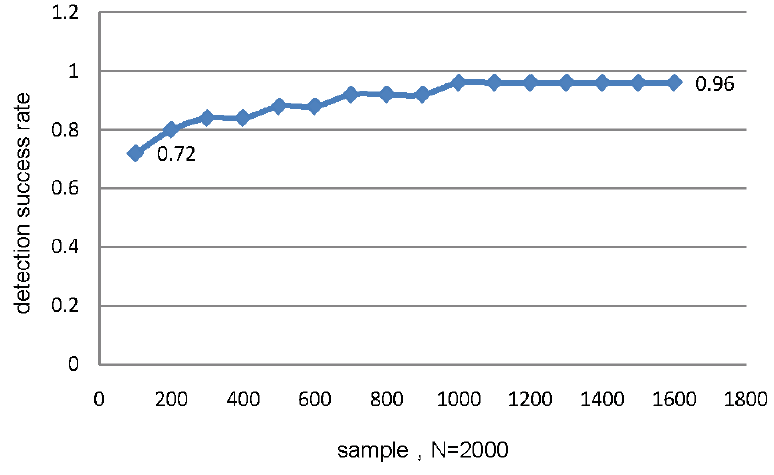
Figure 11. Probability of the compressive fault